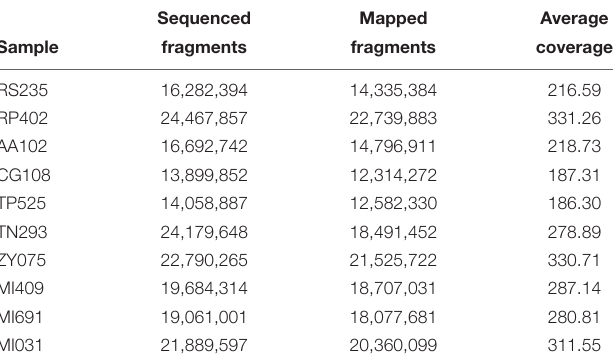
TABLE 3 | Details of sequenced fragments for each strain of Saprochaete isolated from Verona and Milan. Sequenced Mapped Average